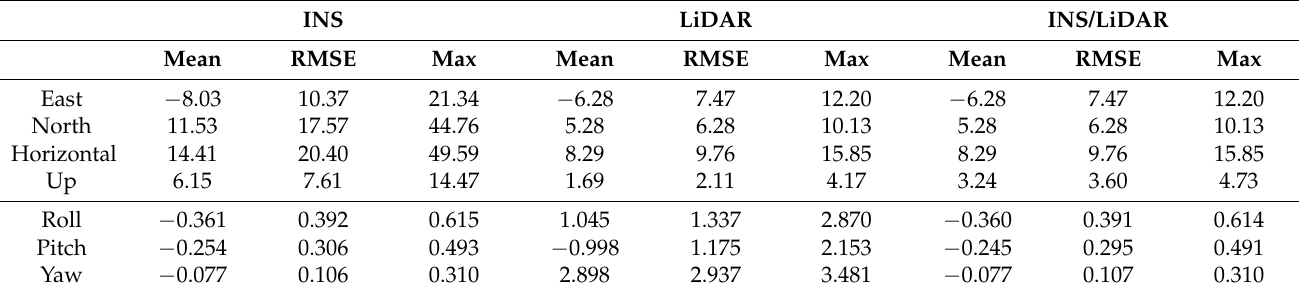
Table A11. D-39—position (m) and attitude (deg) error statistics.